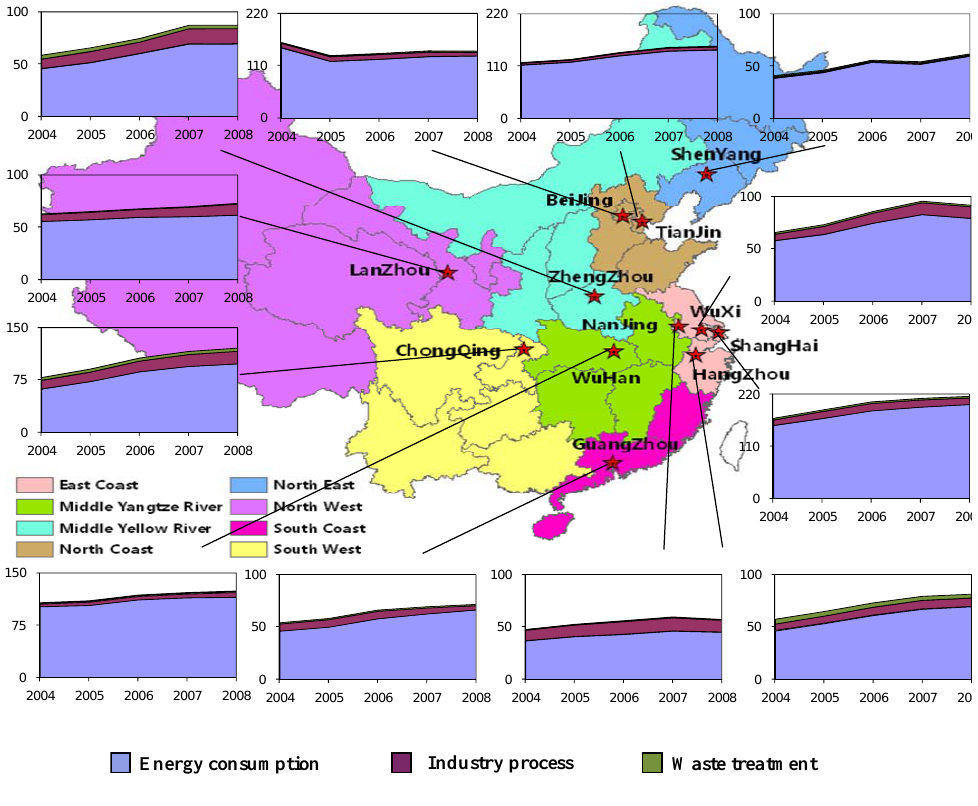
Fig. 1. Carbon emissions of the 12 cities in China from 2004 to 2008, million tons. 471